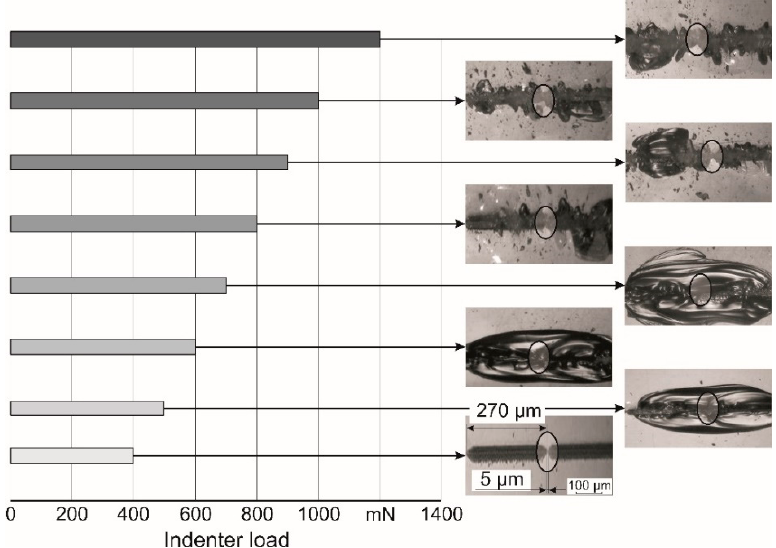
Figure 10. Micro photos of two adjacent scratches 270 µm long, obtained by scratching heavy flint TF- 2 glass with different indenter loads.